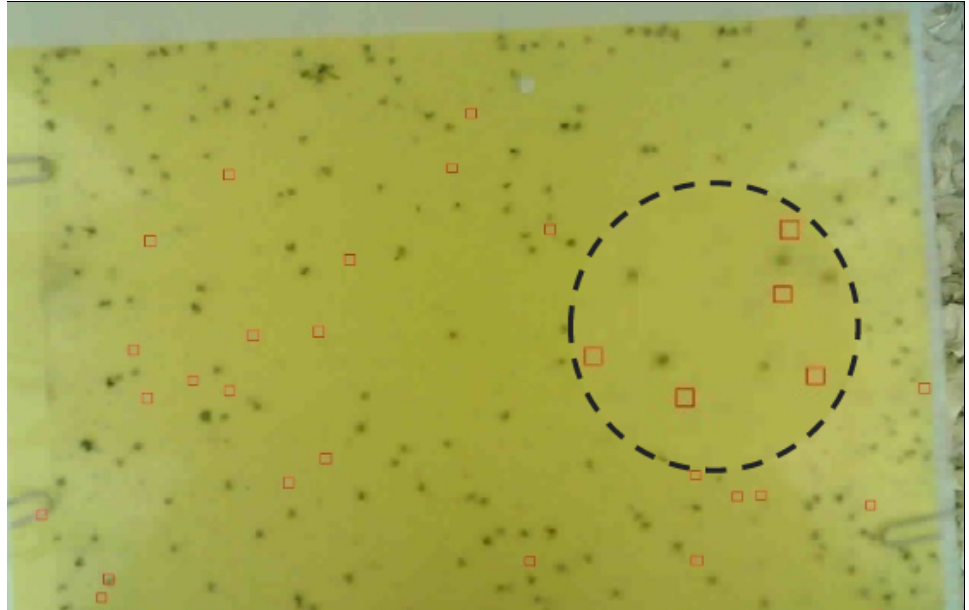
Figure 10. Example of a daily pest detection by the CV model.